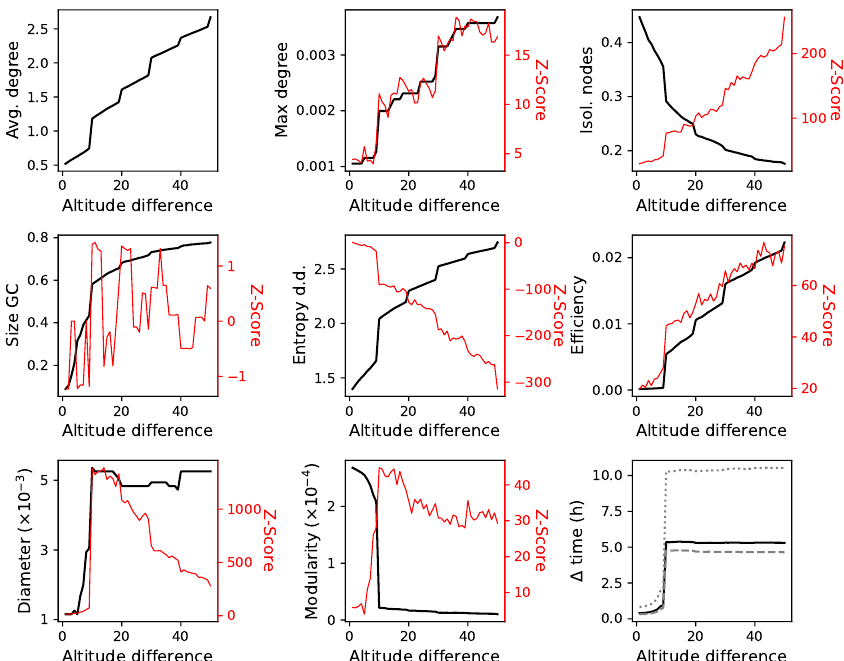
Figure A7. Properties of the interaction networks, for the planned trajectories of 1 September 2018 and ρ = 10 NM, as a function of the altitude difference. Black (left Y axes) and red lines (right Y axes), respectively, correspond to the raw values and their Z-Scores.